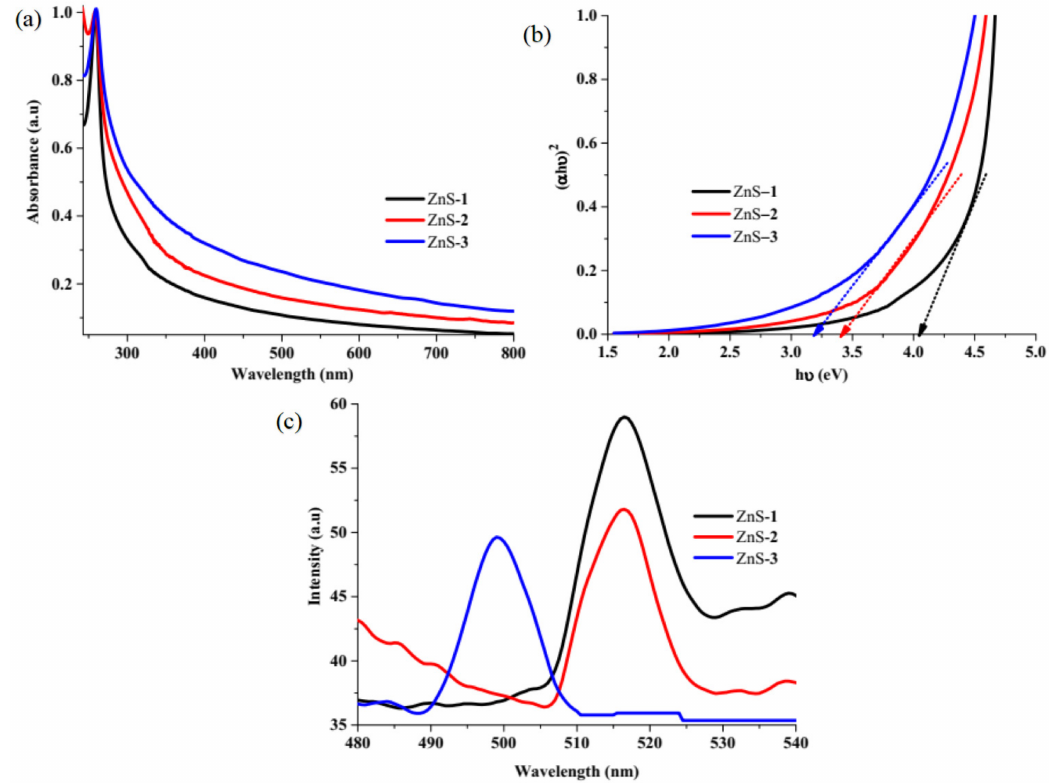
Figure 3. ZnS quantum dots absorption spectra ( a ), Tauc plots ( b ), and photoluminescence spectra ( c